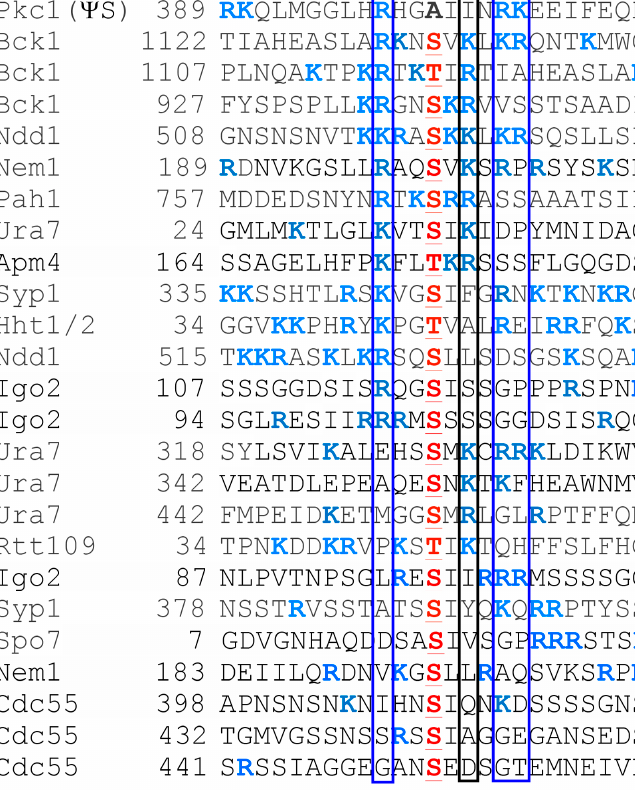
Figure 7. Reported sites of Pkc1 phosphorylation. The evidence for Pkc1 phosphorylation of the indicated site (red) in the gene products listed (position of first residue in the sequence shown indicated on the left) can be found described in the following citations: Amp4 [237]; Bck1 [215,238]; Cdc55 [239]; Hht1 and Hht2 [240]; Igo2 [239]; Ndd1 [241]; Nem1 [233]; Pah1 [233]; Rtt109 [240]; Syp1 [242]; and, Ura7